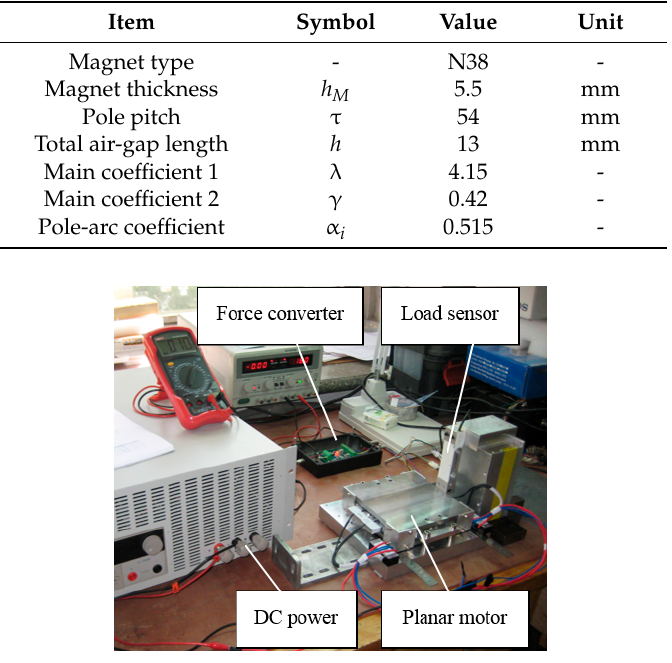
Figure 12. Planar motor force experimental system. (DC: Direct Current)